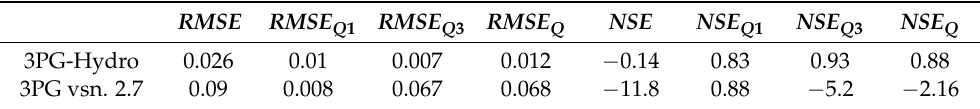
Figure 4. Comparison of volumetric soil water content ( θ ) simulation by 3PG-Hydro and 3PG vsn. 2.7 at Conventwald over the period of 3 years. Dark grey: mean of observed θ ; light grey polygon: lower limit first quartile of observed θ , upper limit thrd quartile of observed θ . Table 2. Performance evaluation of 3PG-Hydro and 3PG vsn. 2.7. Observations, N = 1096. RMSE respectively (m 3 × m − 3